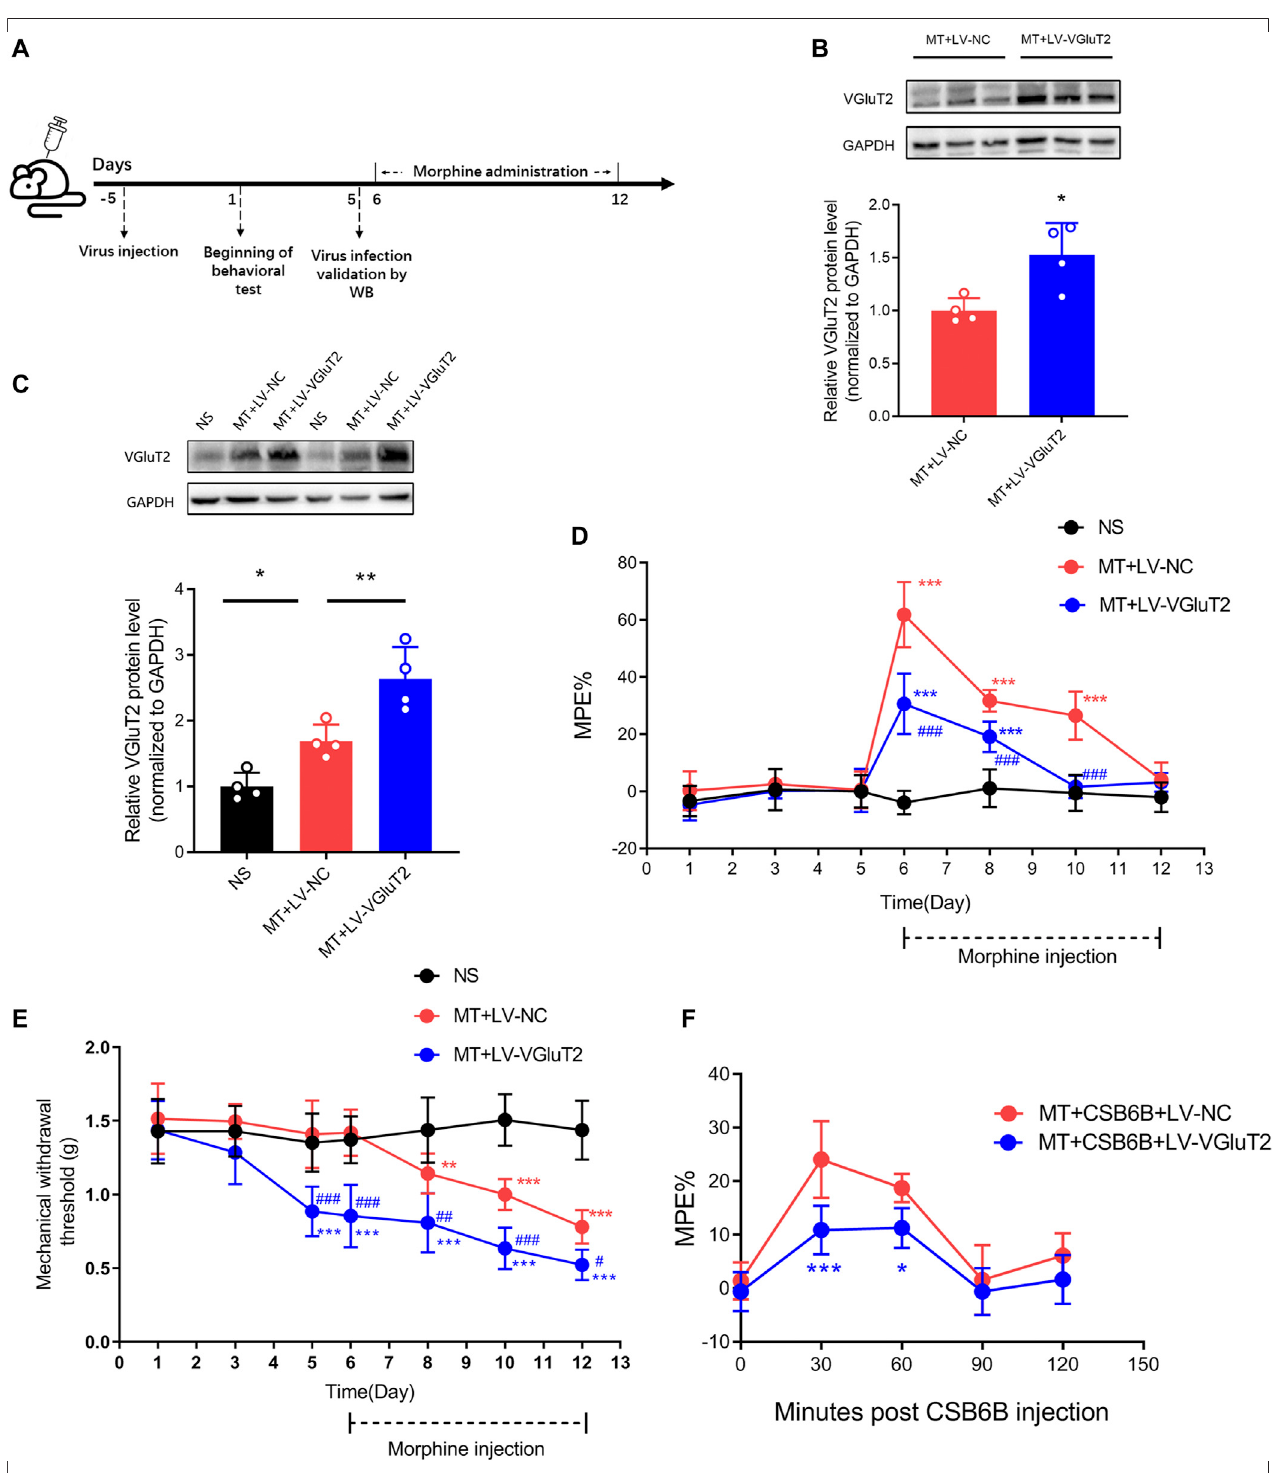
FIGURE 4 | Overexpression of VGluT2 promotes the development of morphine tolerance (A) Experimental schematic diagram showing virus injection, behavioral tests, virus ef fi ciency validation as well as morphine administration in mice expressing scrambled RNA and VGluT2 (B,C) Western blotting test showing ef fi cient VGluT2 overexpression in the spinal cord (B) VGluT2 expression changes 10 days after an intrathecal lentivirus injection (7.5 μ L with a titer of 1×10 9 TU/mL). n = 4, Student ’ s unpaired t -test, t= 3.239, p =0.0177, * p < 0.05, compared withMT + LV-NC (C) The expression changesof VGluT2 after consecutive morphine injections on day 12. n = 4, one-way ANOVA, F (2, 9) = 23.55, p = 0.0003 with Bonferroni correction; * p < 0.05, ** p < 0.01. Western blotting test was performed 10 and 17 days after